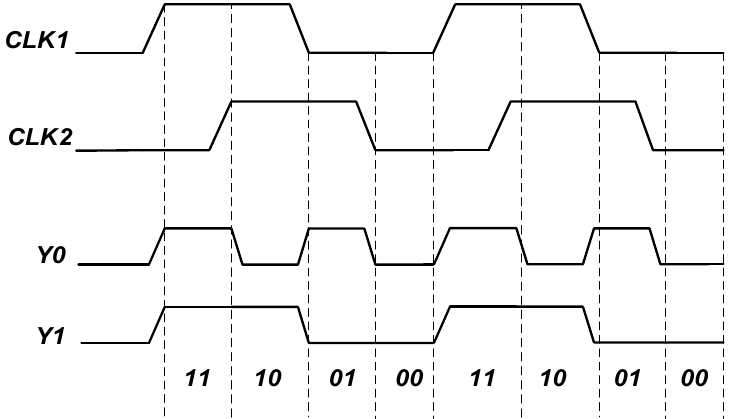
Figure 5. Schematic diagram of the principle of TDC level coding.